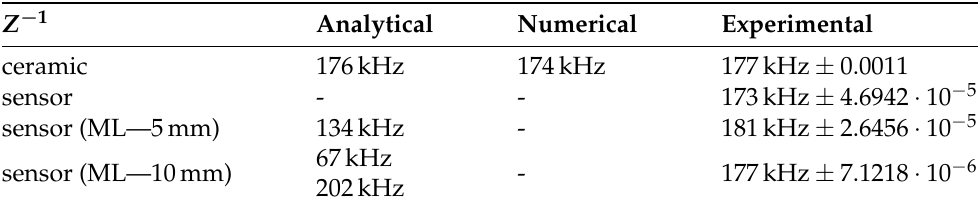
Table 2. Experimental results obtained from electrical admittance for analytical, numerical, and experimental